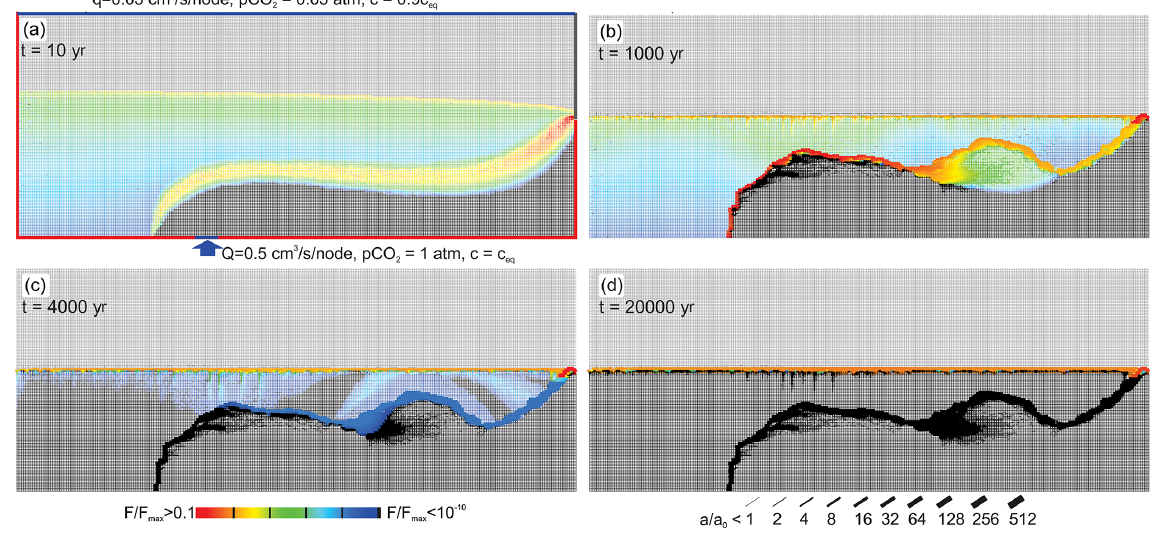
Figure 14. Temporal evolution of scenario B. See text.